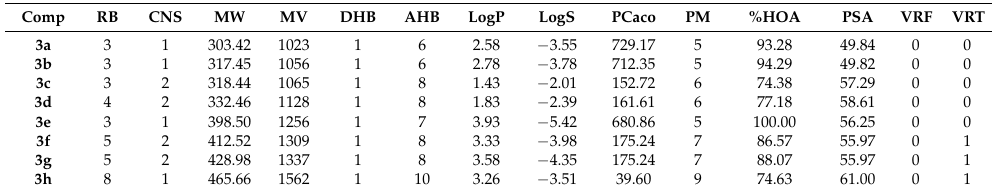
Some physicochemical parameters of the compounds 3a – 3h used in prediction of ADME